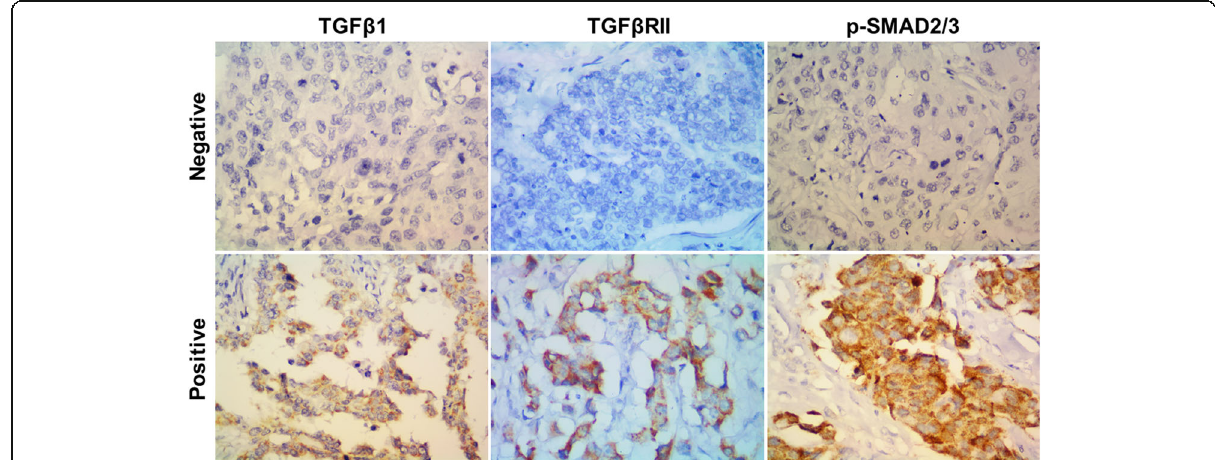
Fig. 1 Representative photomicrographs showing BC tumor sections with negative (top panel) and positive (bottom panel) staining for TGF β 1, TGF β RII and p-SMAD2/3. 400X magnification